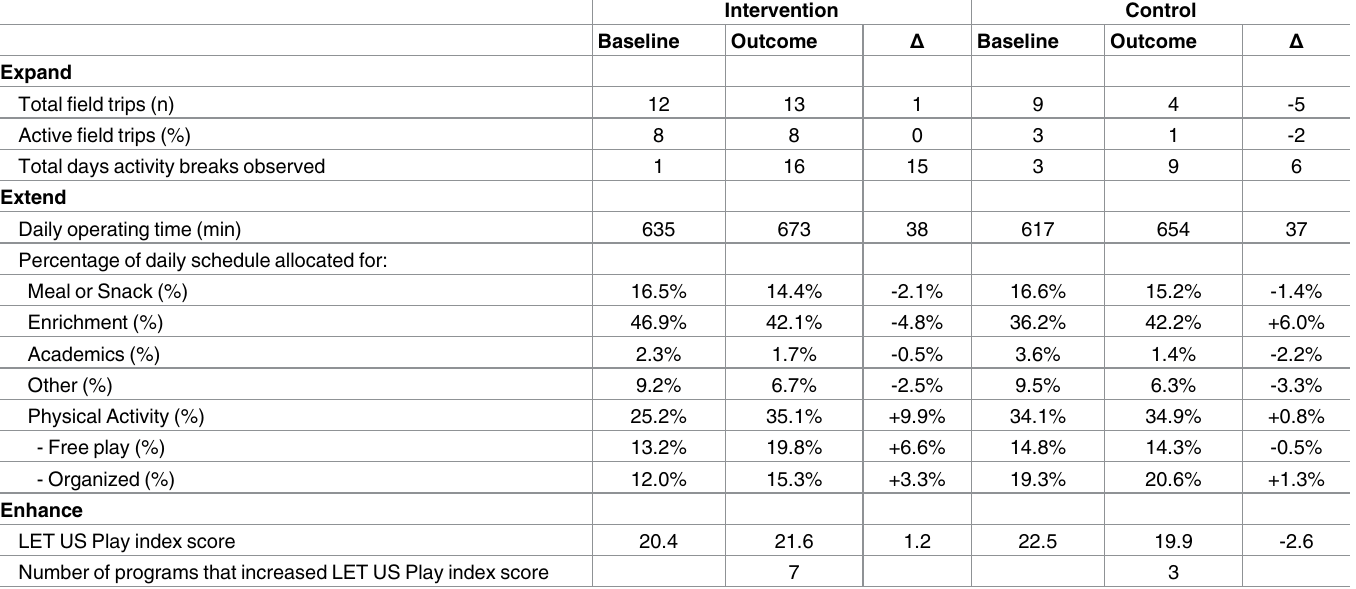
Table 4. Implementation of Expanded, Extended, and Enhanced Physical Activity